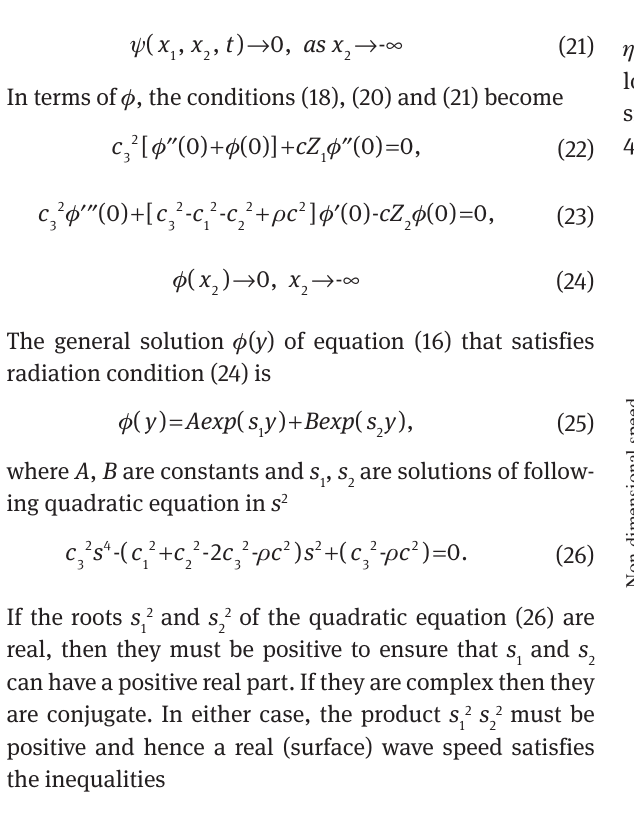
Figure 1: Variation of non-dimensional speed of a Rayleigh wave against the non-dimensional material constant ξ , when ∗ (solid curve with centre symbols), ∗ (solid curve), and ∗ (dotted